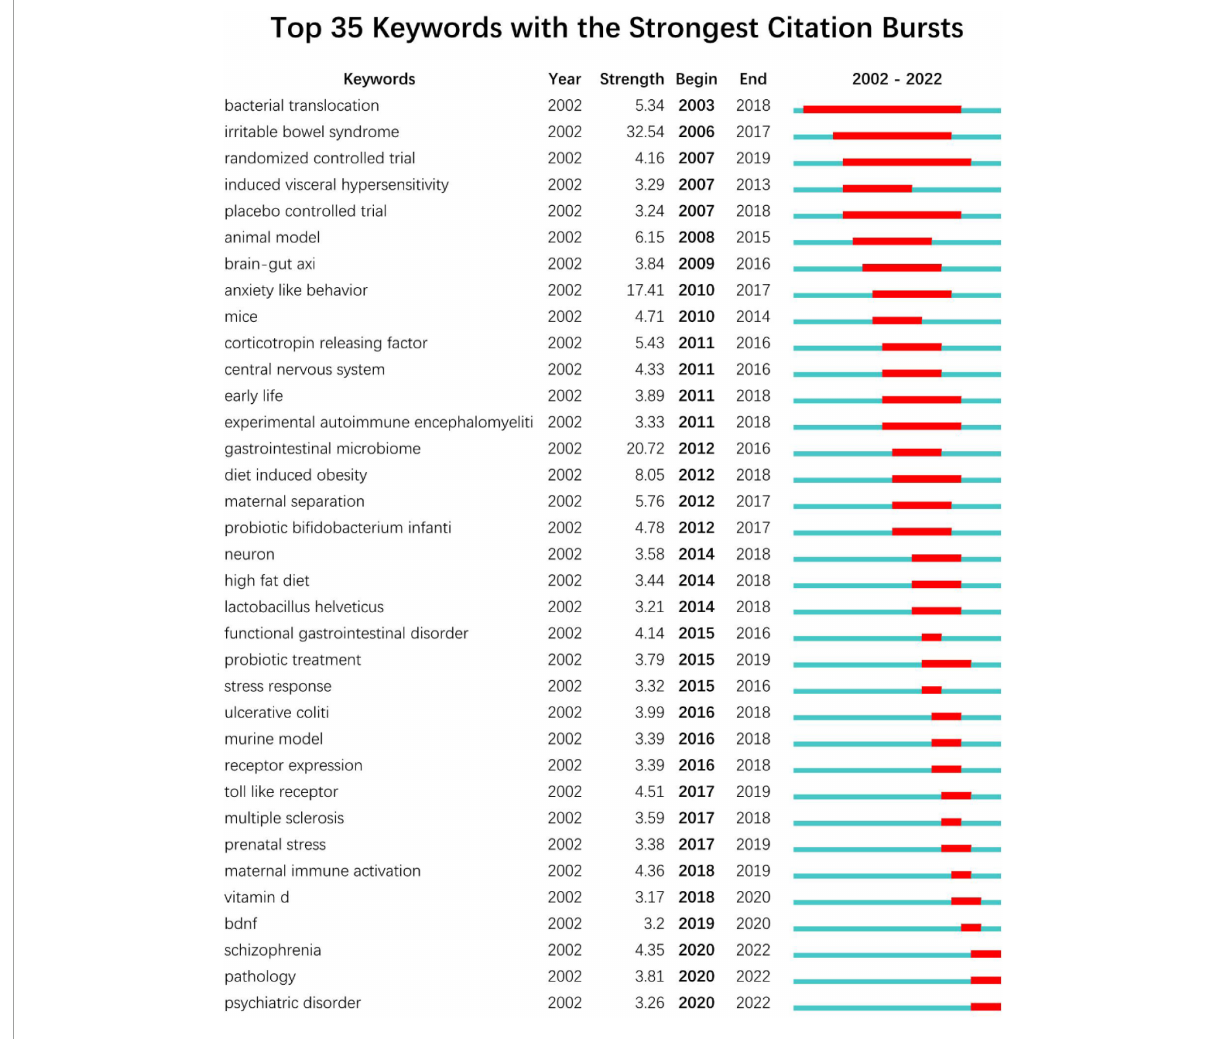
FIGURE8 Top 35 Keywords with the Strongest Citation Bursts (sorted by the beginning year of burst) of the research in gastrointestinal microbiome and neuroscience during